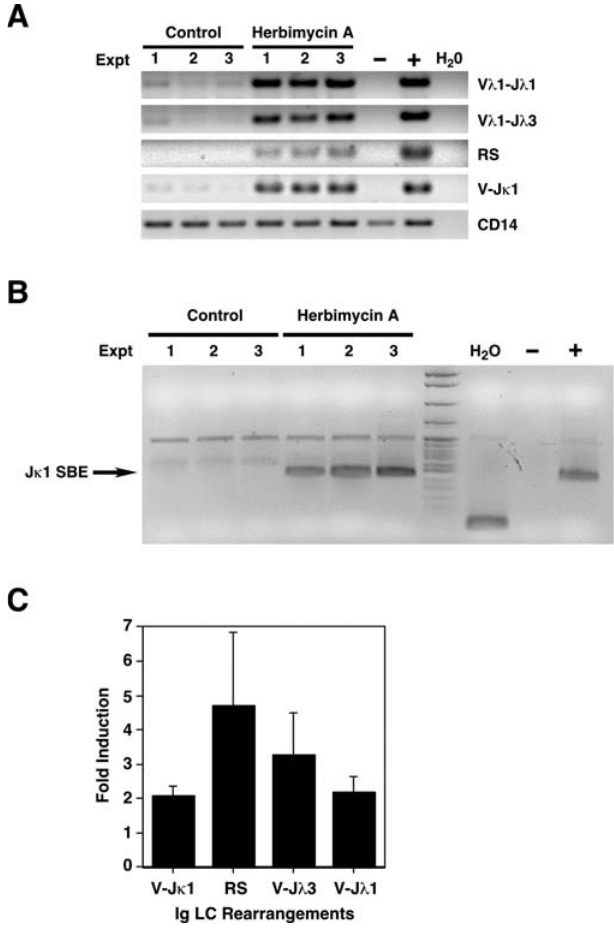
Figure 7. Immature B Cells That Lose Basal Signaling Show Induction of LC Rearrangements (A) PCR analysis of endogenous Ig light chain rearrangements (V-J k 3, V-J k 1, RS, and V-J j 1) in genomic DNA of FACS-sorted